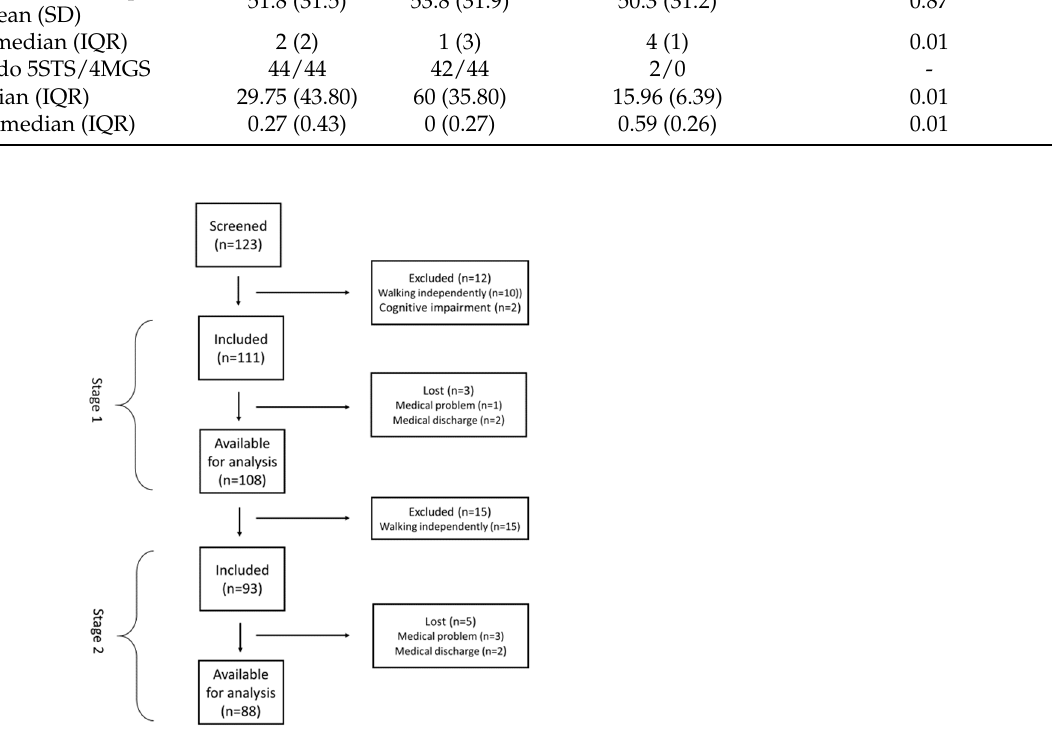
Figure 2. Flowchart of patients who met inclusion/exclusion criteria for the study population. Table 1. Baseline demographics and overall stroke patient characteristics in total and separated by walking category. SD = standard deviation; PT = physical therapy; FAC = Functional Ambulation Category; IQR = interquartile range; 5STS =